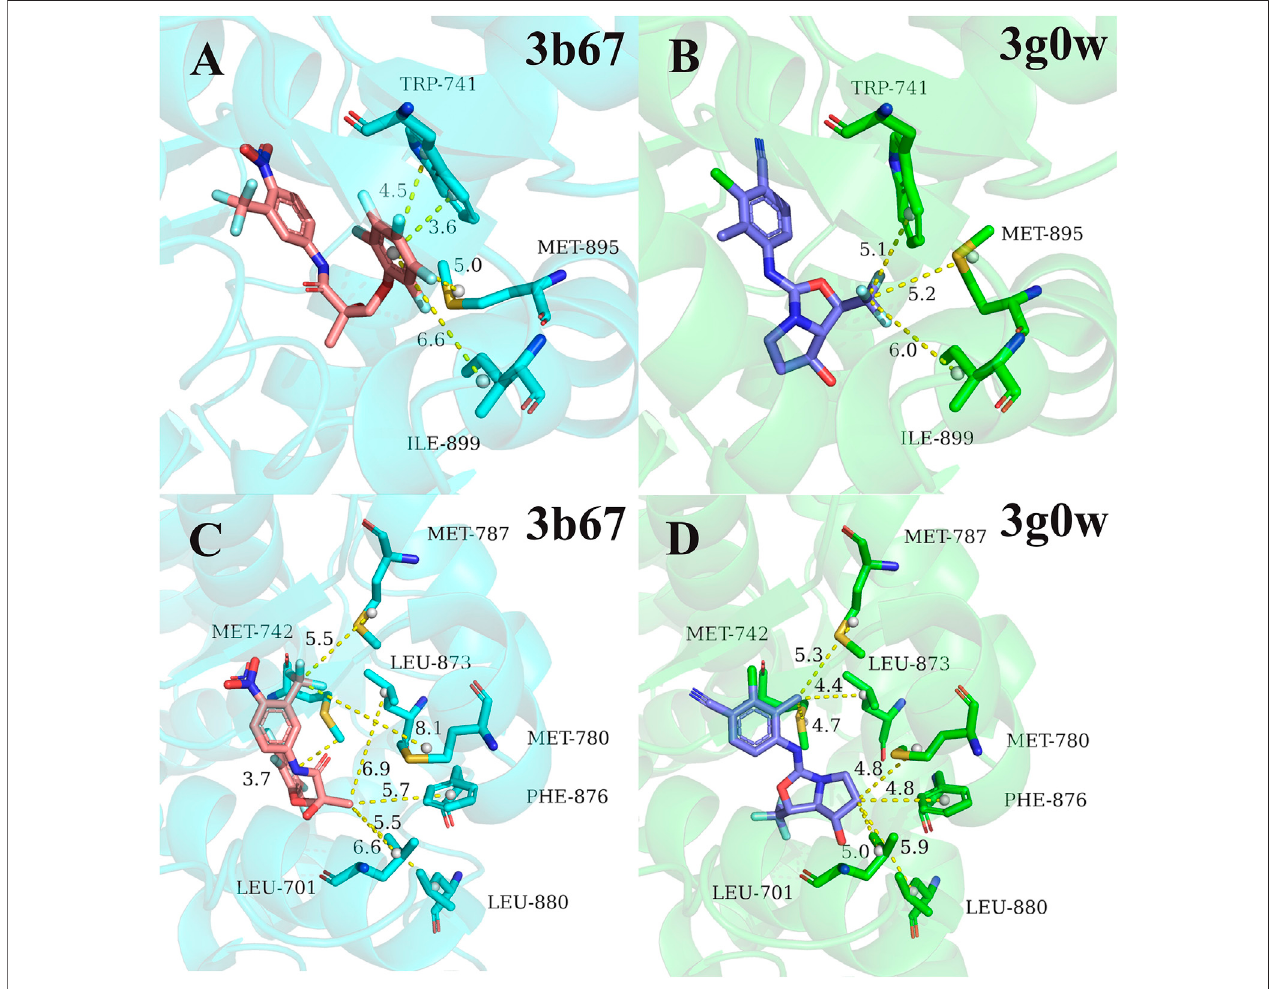
FIGURE4| Comparisonofpocketresiduesin3b67(Bohletal.,2008)(cluster2)and3g0w(Nirschletal.,2009)(cluster3).Therelativepositionofresidues741TRP, 895MET, 899ILE in 3b67 (A) and 3g0w (B) with the ligand in the crystal structure. The relative position of the residues 701LEU, 742MET, 780MET, 787MET, 873LEU, 876PHE, 880LEU in the crystal structure tothe ligand in3b67 (C) and 3g0w (D) . Thedashed lines and numbers indicated distance(in Å) betweenthe speci fi cgroups of the ligands and residues.